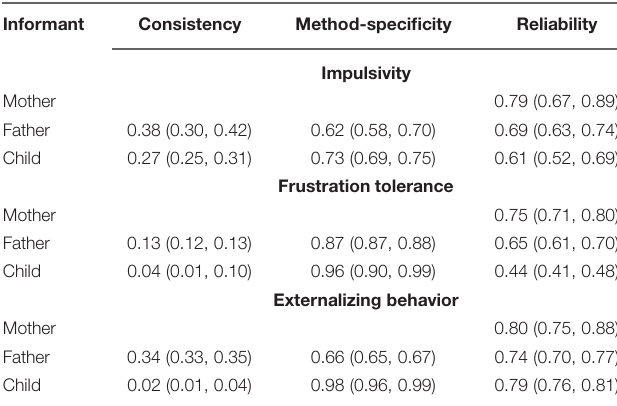
TABLE 1 | Consistency, method-specificity, and reliability estimates obtained from the CT-C( M – 1) mediation